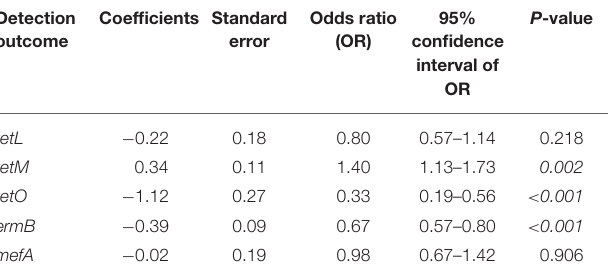
TABLE 9 | The five logistic regression models depicting the association between year of isolation and the detection of tetL , tetM , tetO , ermB , and mefA among Streptococcus uberis ( n = 228) associated with bovine mastitis in northern Thailand during